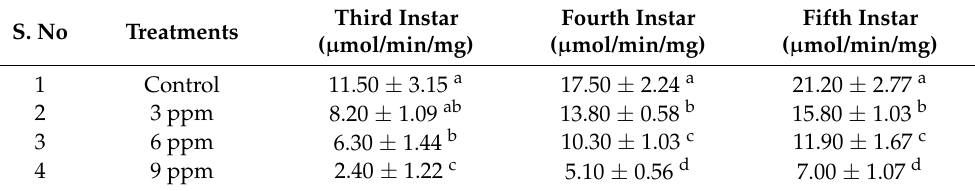
Table 3. Effect of andrographolide on digestive enzyme protease of S. litura.